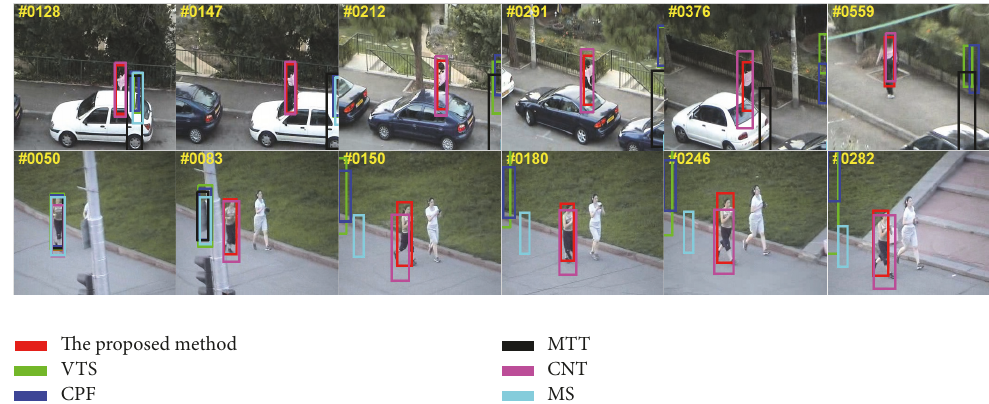
Figure 6: Qualitative evaluation about the trackers on sequences woman and jogging-1 seq.